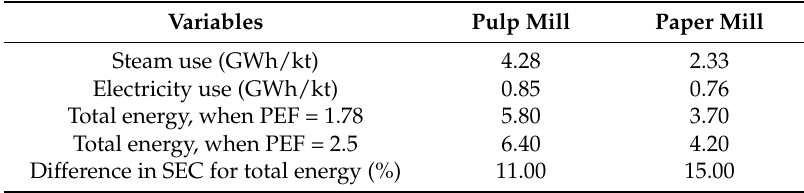
Table 3. Specific individual energy carriers’ use and specific total energy use, calculated using PEF 1.78 and 2.5. Specific individual energy carriers’ use has been calculated from Farahani et al.